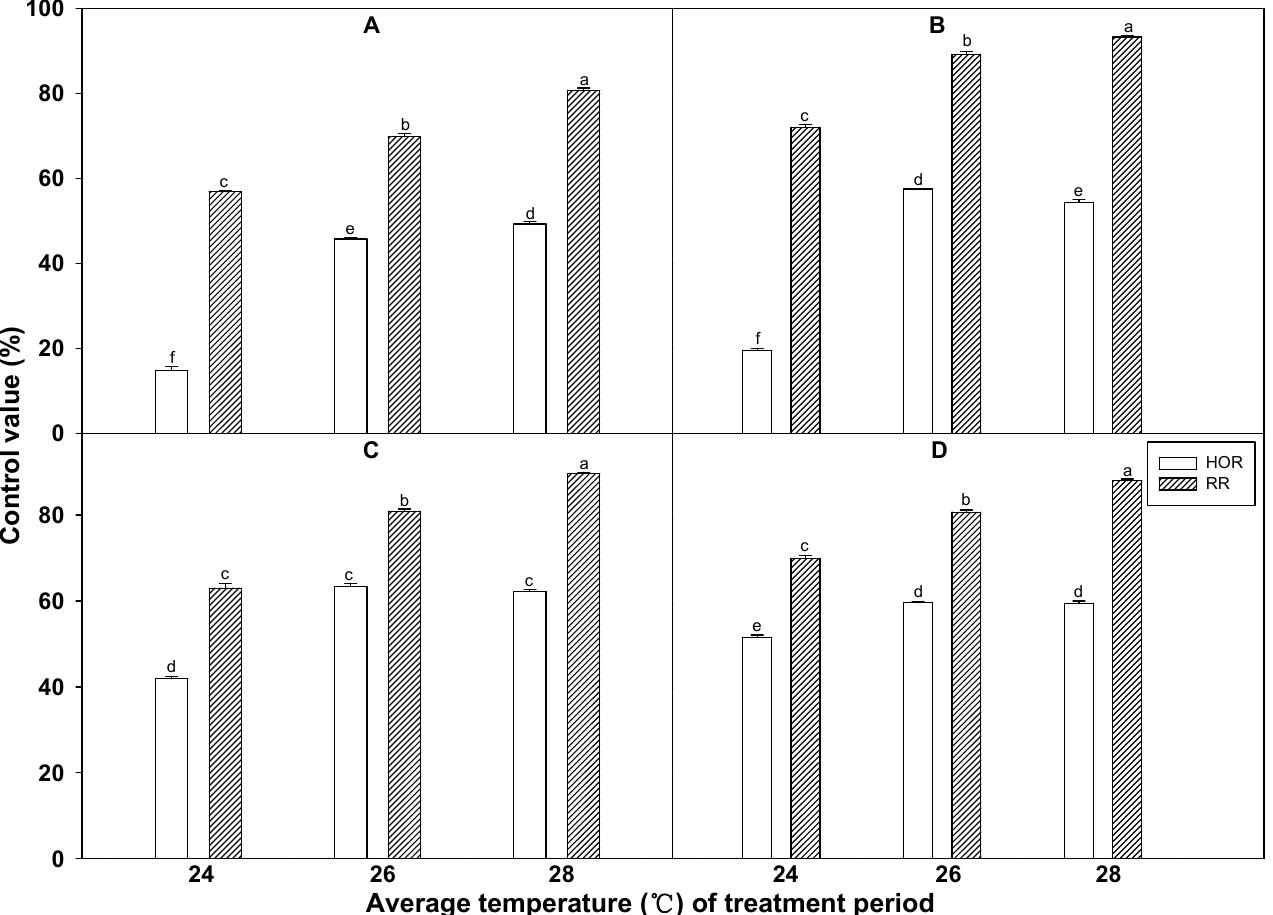
Figure 11. Control value (%) of A. patulus in response to foliar herbicides ( A . glyphosate isopropylamine; B . glufosinate- ammonium; C . bentazone; D . mecoprop) at different average temperatures in greenhouses. HOR: Half of the recommended rate; RR: Recommended rate. Means within bars followed by the same letters are not significantly different at the 5% level according to Duncan’s Multiple Range Test. Error bars represent SE.